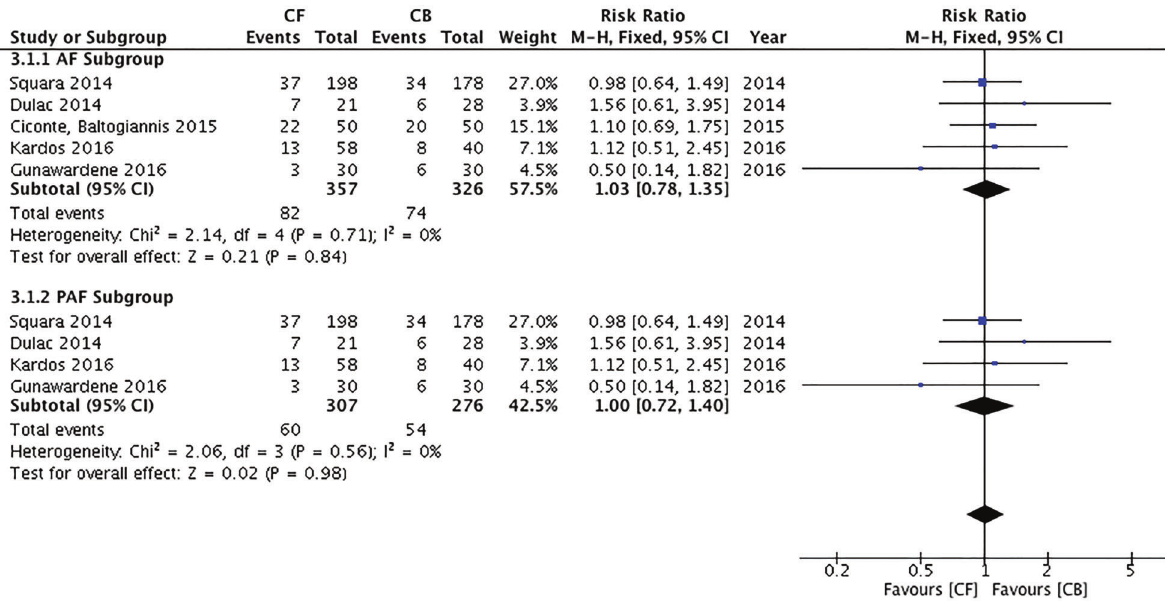
Figure 5. Forest plot showing risk ratios and 95%CI for atrial fi brillation recurrence within 12 months for studies comparing contact force (CF) and cryoballoon (CB) groups.